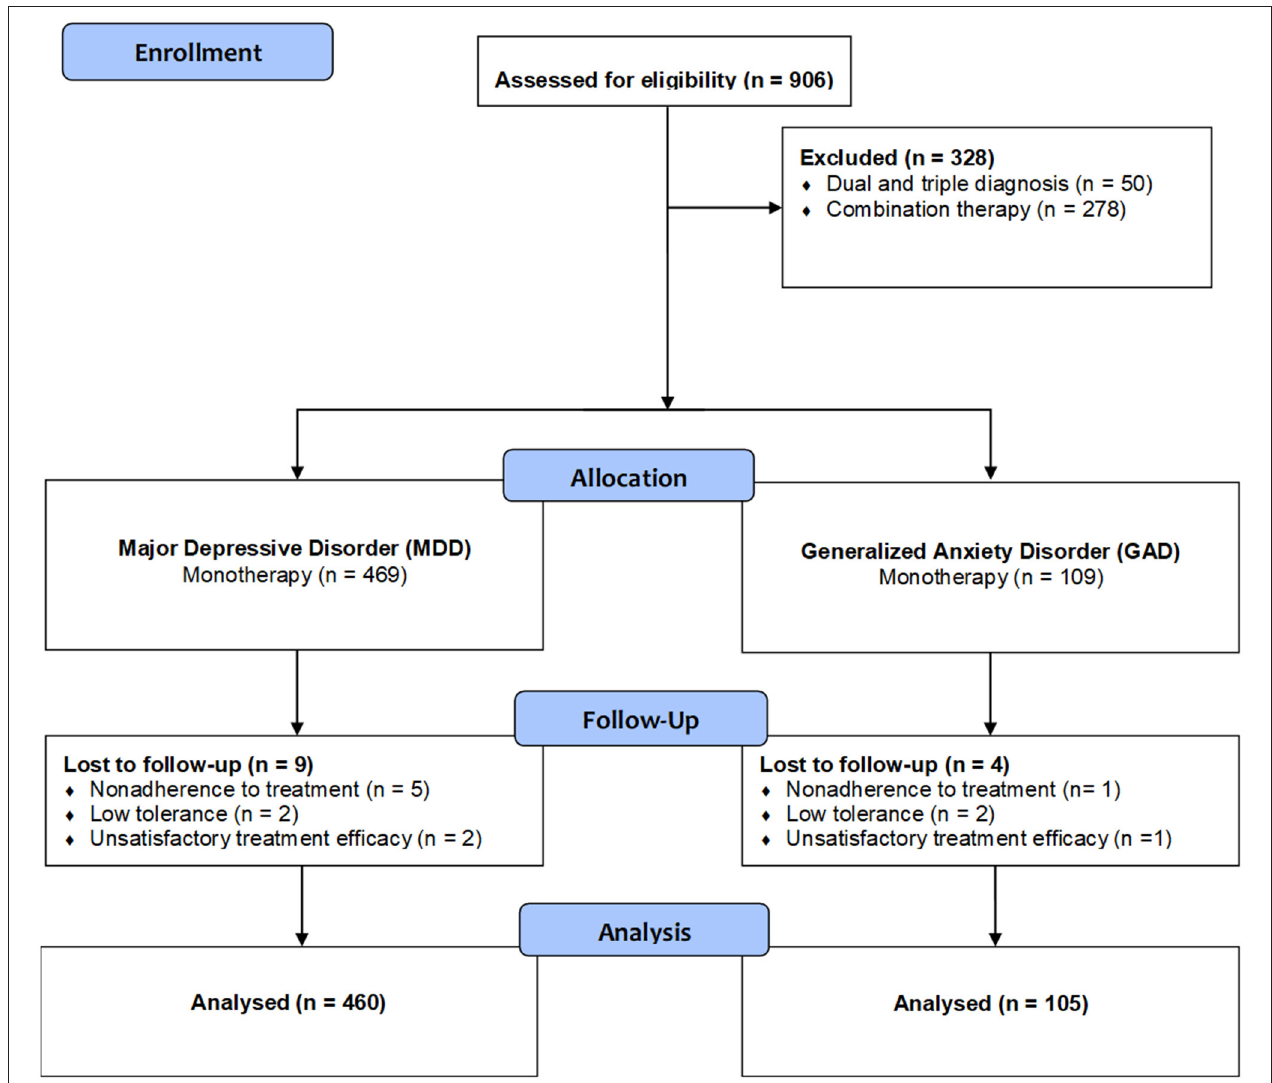
FIGURE 1 | Flowchart of the progression of participants through the